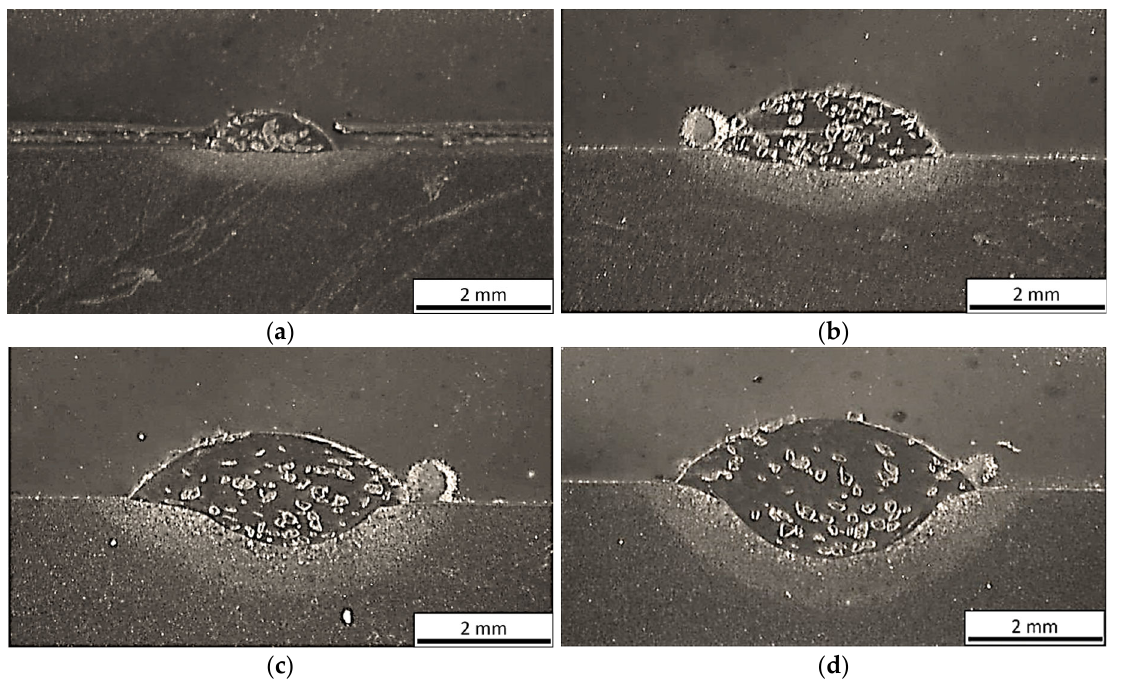
Figure 5. Representative macrostructure and single bead geometry of the clad layers produced by laser cladding of experimental composite NiCrBSi/WC + W 2 C powder at different laser output power, Tables 1 and 2: ( a ) 500 W; ( b ) 1000 W; ( c ) 1500 W; ( d ) 2000 W.